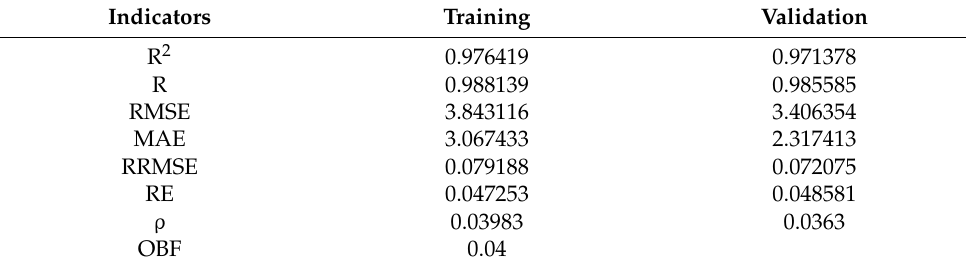
Table 5. Statistical indictors for training and validation